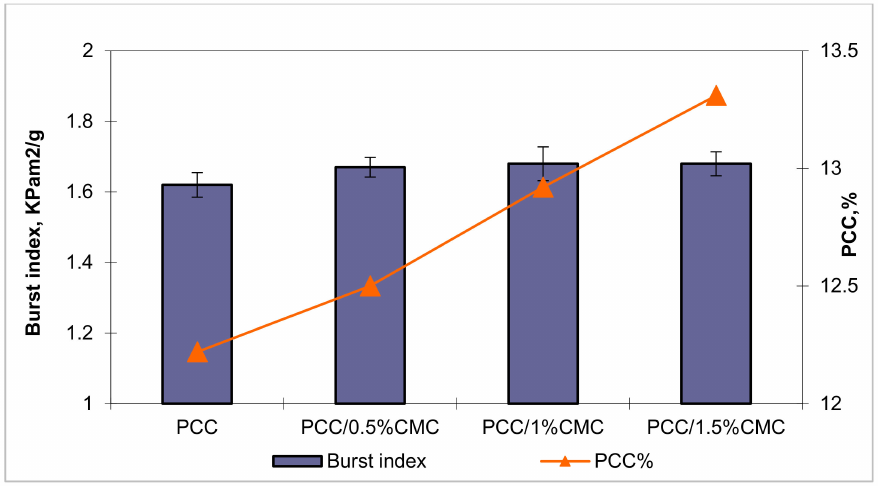
Figure 10. The effect of PCC modified with CMC of different addition levels on burst